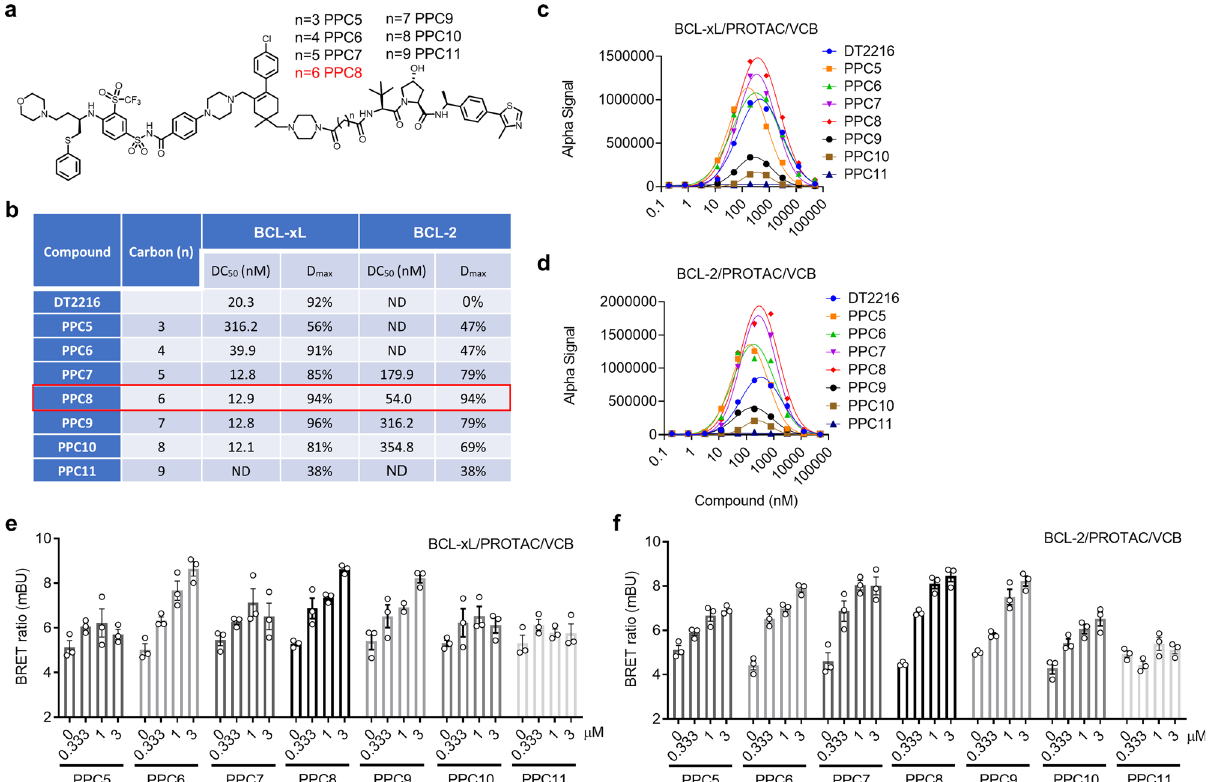
Fig. 2 Synthesis and evaluation of a series of BCL-xL and/or BCL-2 degraders. a The structure of the BCL-xL and/or BCL-2 degraders (racemic mixture). b The BCL-xL and BCL-2 degradation pro fi ling of the PROTACs evaluated in 293T cells after the cells were treated with four different concentrations of indicated PROTACs for 16 h. The DC 50 and D max were calculated using Prism based on the ImageJ-quanti fi ed western blots in Supplementary Fig. 4. c , d AlphaLISA assay to determine the formation of BCL-xL/PROTAC/VHL-ELOC-ELOB (VCB) ( c ) or BCL-2/PROTAC/VCB ( d ) ternary complex in a cell-free condition. Data represent the mean of a single experiment with 2 technical replicates. Similar results were obtained in one more independent experiment. e , f NanoBRET assays evaluating intracellular BCL-xL/PROTAC/VCB ( e ) or BCL-2/PROTAC/VCB ( f ) ternary complex formation. 293T cells were transiently transfected with HiBit-BCL-xL, LgBit, and HaloTag-VHL or HiBit-BCL-2, LgBit, and HaloTag-VHL and then treated with a serial dilution of the indicated compounds for 6 h. Data are expressed as mean ± s.e.m. of three biological replicates. Source data are provided as a Source data fi